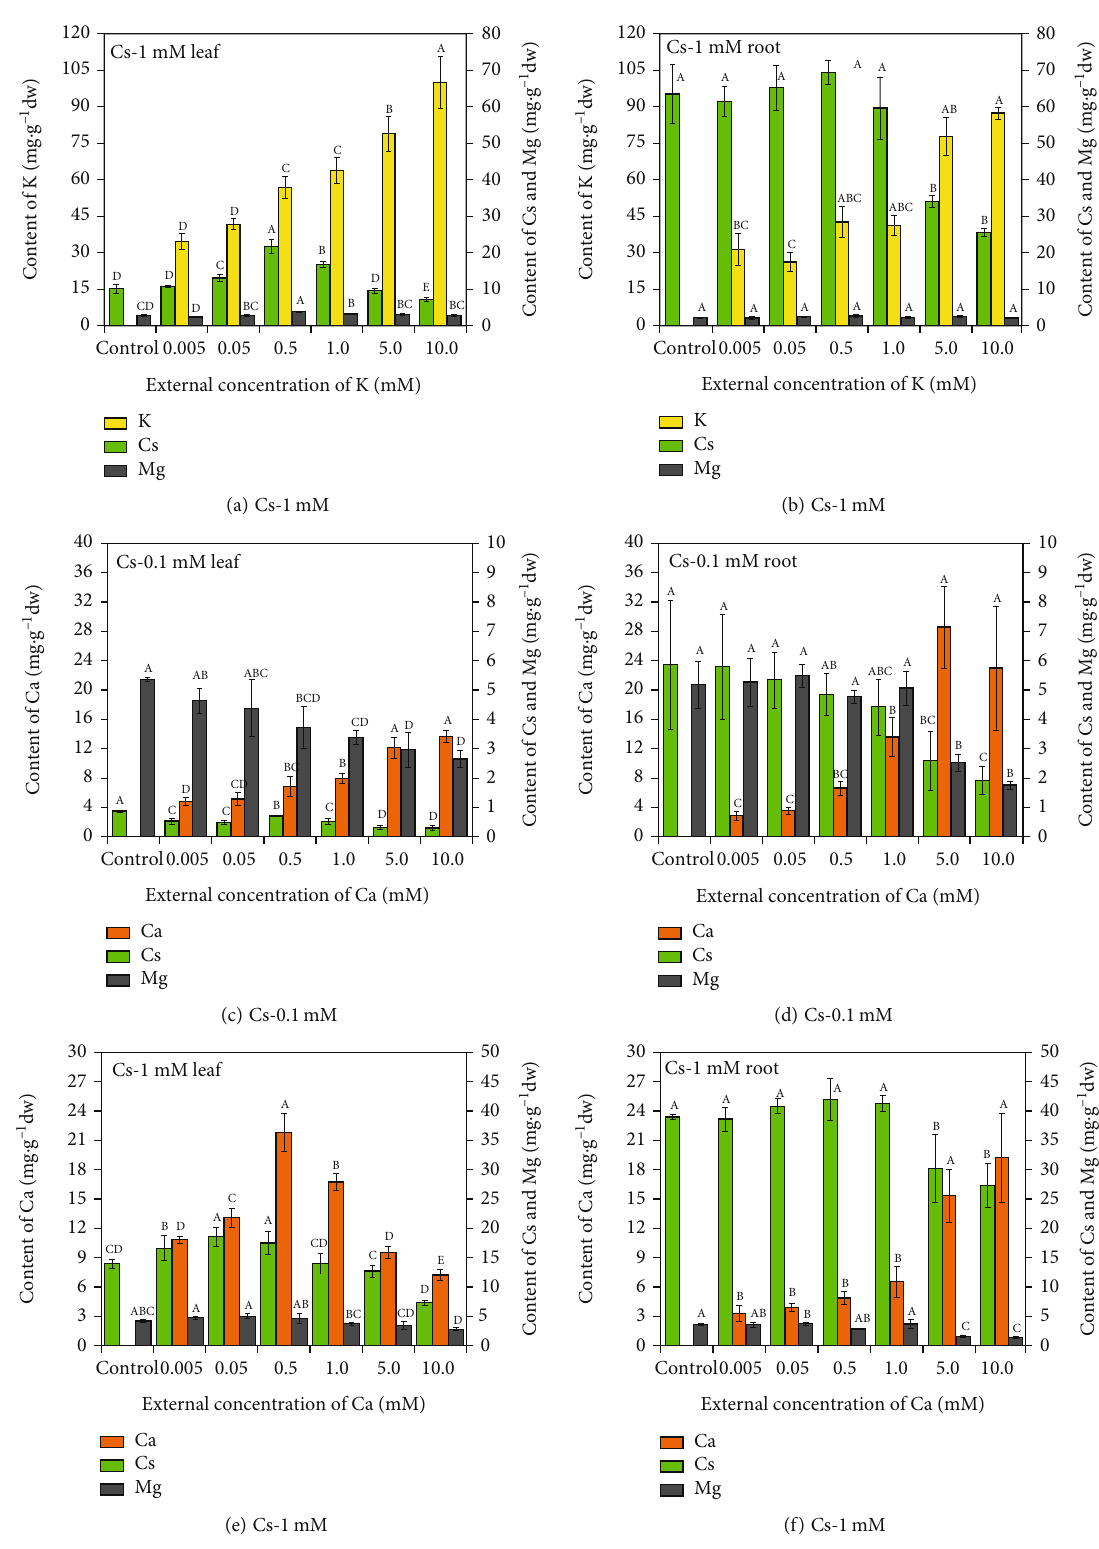
Figure 4: The e ff ect of di ff erent concentrations of K + and Ca 2+ on the uptake of di ff erent ion in lettuces. (a) Cs-1 mM, leaf;and (b) Cs-1mM, root; were ion contents in the leaves and roots of lettuces treated with K + under 1 mM Cs treated. (c) Cs-0.1 mM, leaf; and (d) Cs-0.1mM, root; were ion contents in the leaves and roots of lettuces treated with Ca 2+ under 0.1mM Cs treated. (e) Cs-1 mM, leaf; and (f) Cs-1mM, root. were ion content in the leaves and roots of lettuces treated with Ca 2+ under 1mM Cs treated. Notes: the di ff erent lowercase letters indicate that signi fi cant di ff erences ( P < 0 : 05 ) exist between treatment groups with di ff erent Cs levels in lettuce (LSD